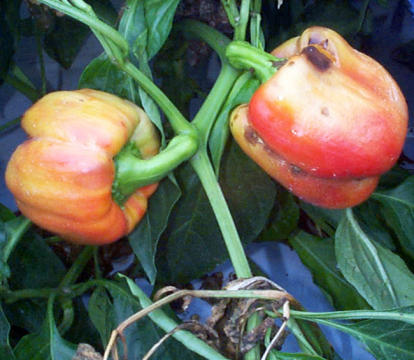
The human gut appears to harbor infectious strains of the pepper mild mottle virus (seen infecting peppers, above), suggesting that humans may serve as vector for certain plant viruses. Image: UF/IFAS Pest Alert Web site/Pamela Roberts